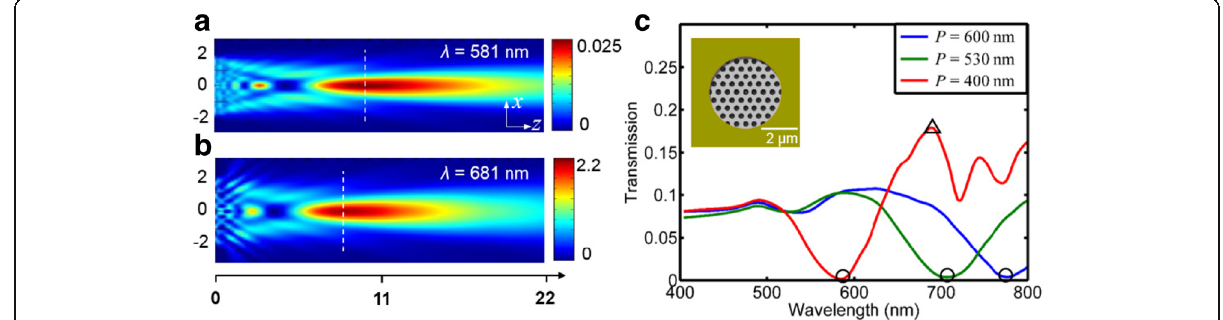
Fig. 6 a , b Simulation results of the electric-field patterns of the 4- μ m microlens when P = 400 nm at the working wavelength of λ = 581 nm (transmission dip) and 681 nm (peak), respectively. c Simulated total transmittance spectra for the microlenses corresponding to the lattice spacings P =400, 530, and 600 nm in the frequency range of 400~800 nm, and the inset shows the model of a 4- μ m microlens. The transmission dips and peak are flagged by circles and triangle ,